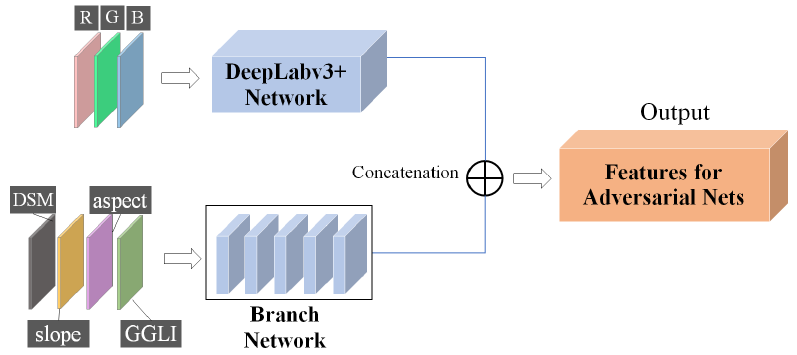
Figure 2. Architecture of multisource data fusion